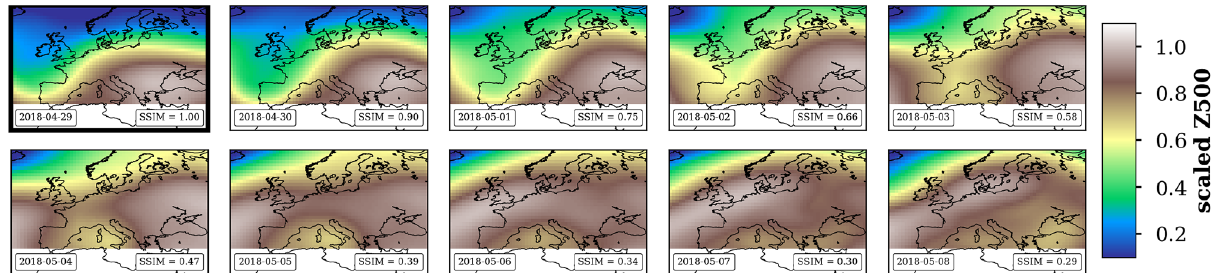
Figure 10. Illustration of the Structural SIMilarity (SSIM) image comparison approach applied to 10 successive atmospheric circulation patterns (scaled Z500) over Europe from 2018–04–29 (reference image, upper left) to 2018–05–08 (lower right). The reference image shows a trough over Western Europe. The SSIM values are given in the lower right box, respectively. The maps were created by using python3-mpltoolkits.basemap (version 1.2.1, https:// matpl otlib. org/ basem